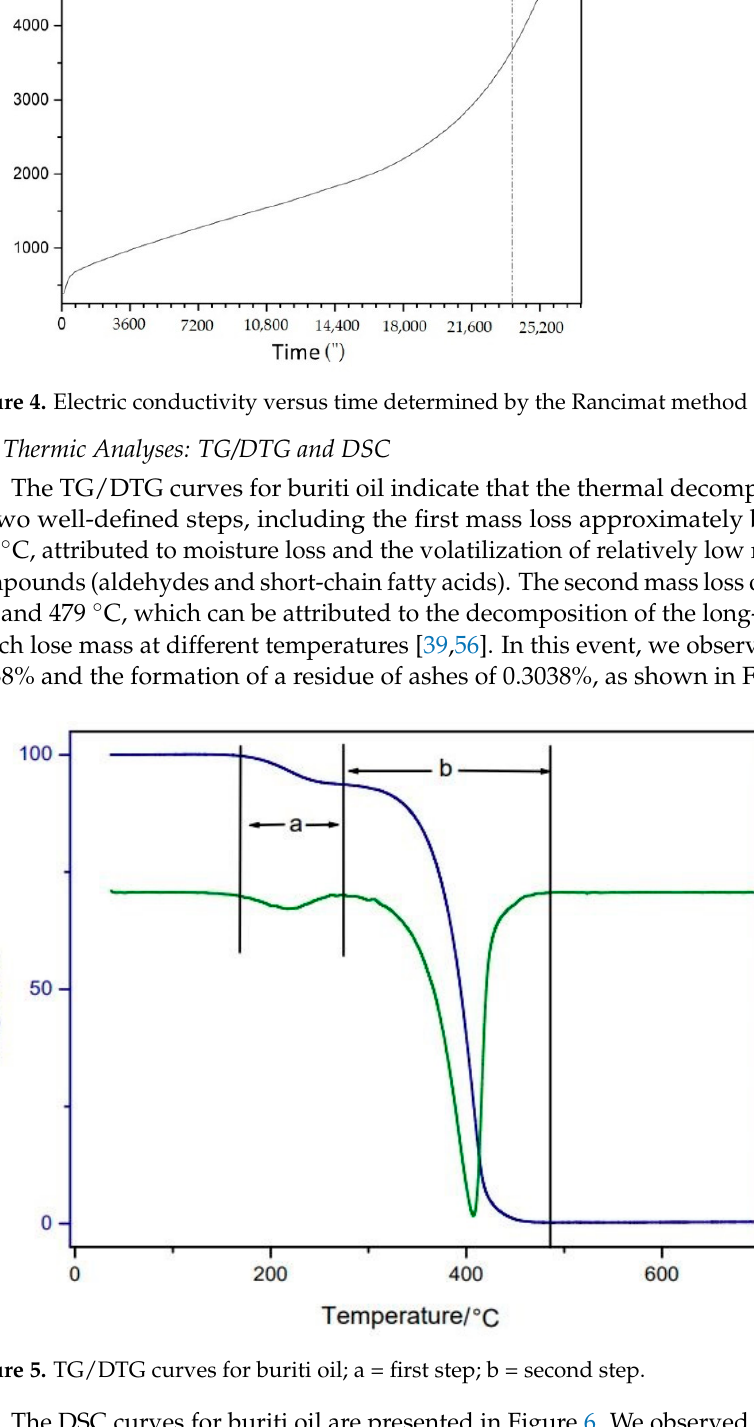
11 of 23 Figure 3. Emission–excitation map of buriti oil diluted in hexane at 5 g/L. 3.4. Oxidative Stability: Rancimat